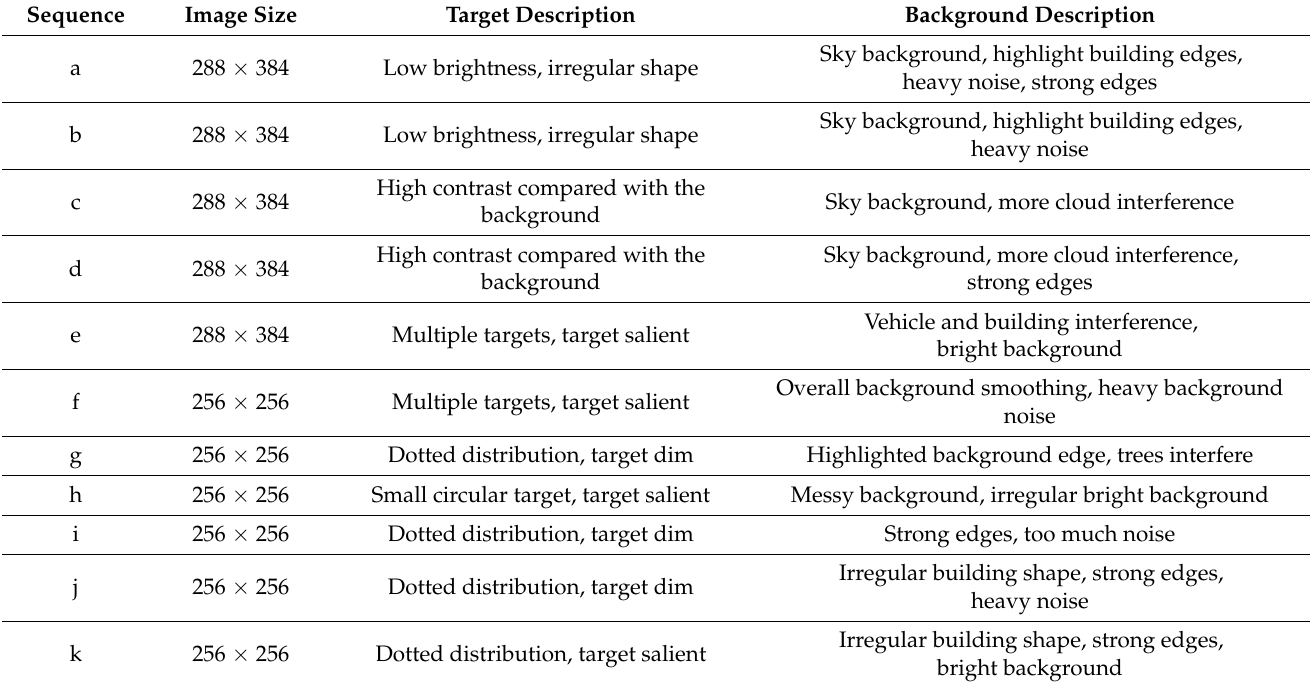
Table 1. Features of the